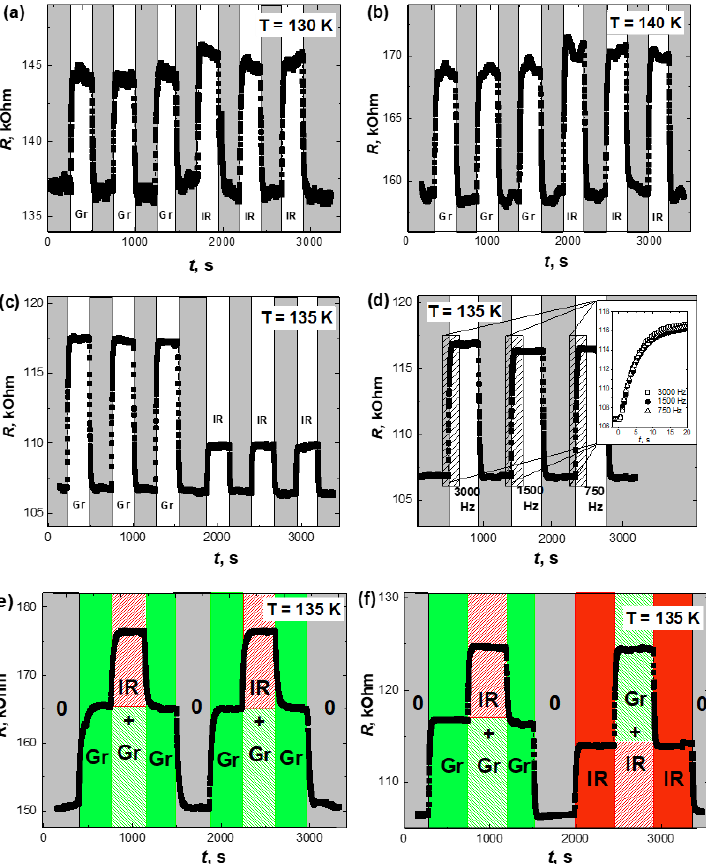
Figure 3. ( a , b ) The multiple on-off switching of electrical resistance of the Ba 0.8 Sr 0.2 TiO 3 /LaMnO 3 heterostructure at 130 K ( a ) and 140 K ( b ) by the green (wavelength 514 nm) and infrared (wavelength 1028 nm) illumination of the same intensity (80 mW/cm 2 ), starting with the dark state. ( c ) The multiple on-off switching of electrical resistance of the Ba 0.8 Sr 0.2 TiO 3 /LaMnO 3 heterostructure at 135 K by green (80 mW/cm 2 ) and infrared illumination (40 mW/cm 2 ), starting with the dark state. Intensities were scaled to ensure the same flow rate of photons hitting the sample. ( d ) The multiple on-off switching of electrical resistance of the Ba 0.8 Sr 0.2 TiO 3 /LaMnO 3 heterostructure at 135 K by a green (80 mW/cm 2 ) light with a pulse repetition rate of 3 kHz, 1.5 kHz, and 0.75 kHz (starting with the dark state); inset zooms in on the initial period after turning on the light. ( e , f ) Dynamics of the changes in the electrical resistance of a BSTO/LMO/BSTO sample during several superimposed on/off cycles of green (wavelength 514 nm) and infrared (wavelength 1028 nm) radiation at different subsequences at 135 K. The periods of light exposure are marked: 0—dark, Gr—green light, Ir—IR light, and Gr + Ir—simultaneous exposure to green and infrared light (shown in color in the online version).